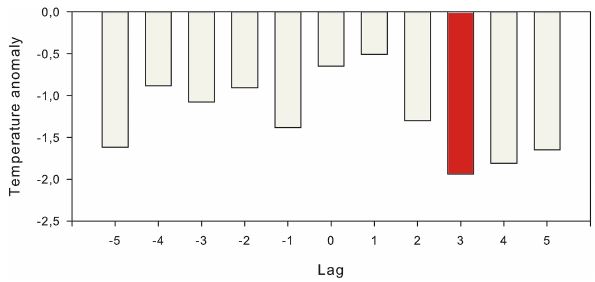
Figure 10. Superposed epoch analysis with a back and forward lag of 5 years. Significance ( p < 0 . 05) at 3 years after the extreme vol- canic events identified in Crowley